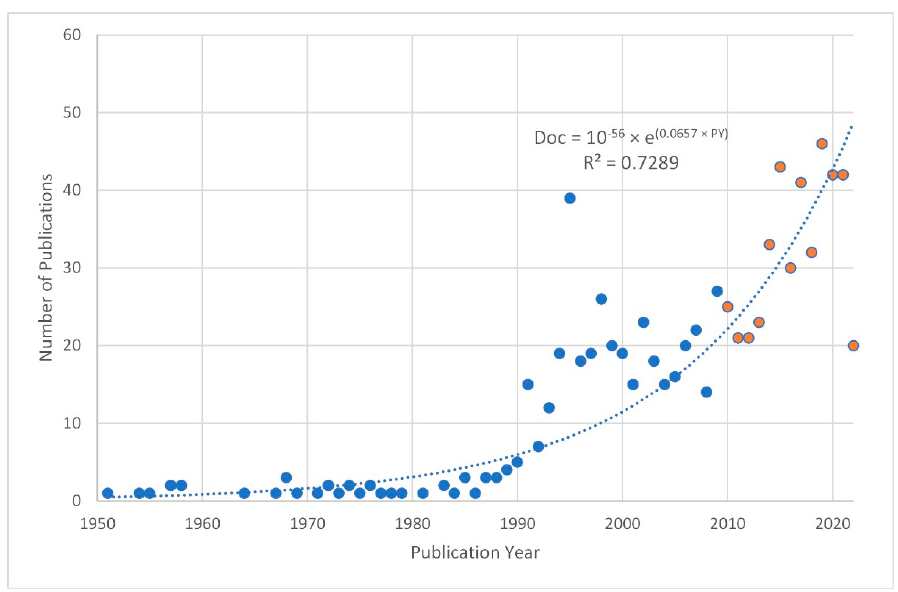
Figure 1. Publications on supervision in psychotherapy between 1950 and 2022. Blue dots, non-contemporary documents in data series; orange dots, contemporary data series; dashed line, exponential data series trend.